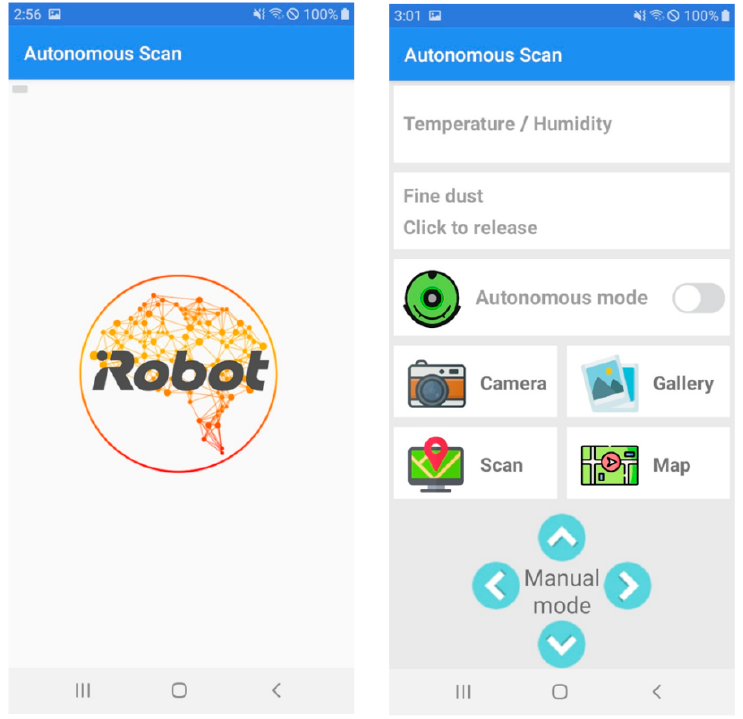
Figure 7. Screenshots of mobile application in proposed system. Intro screen of application ( left ), and control screen of application ( right ).